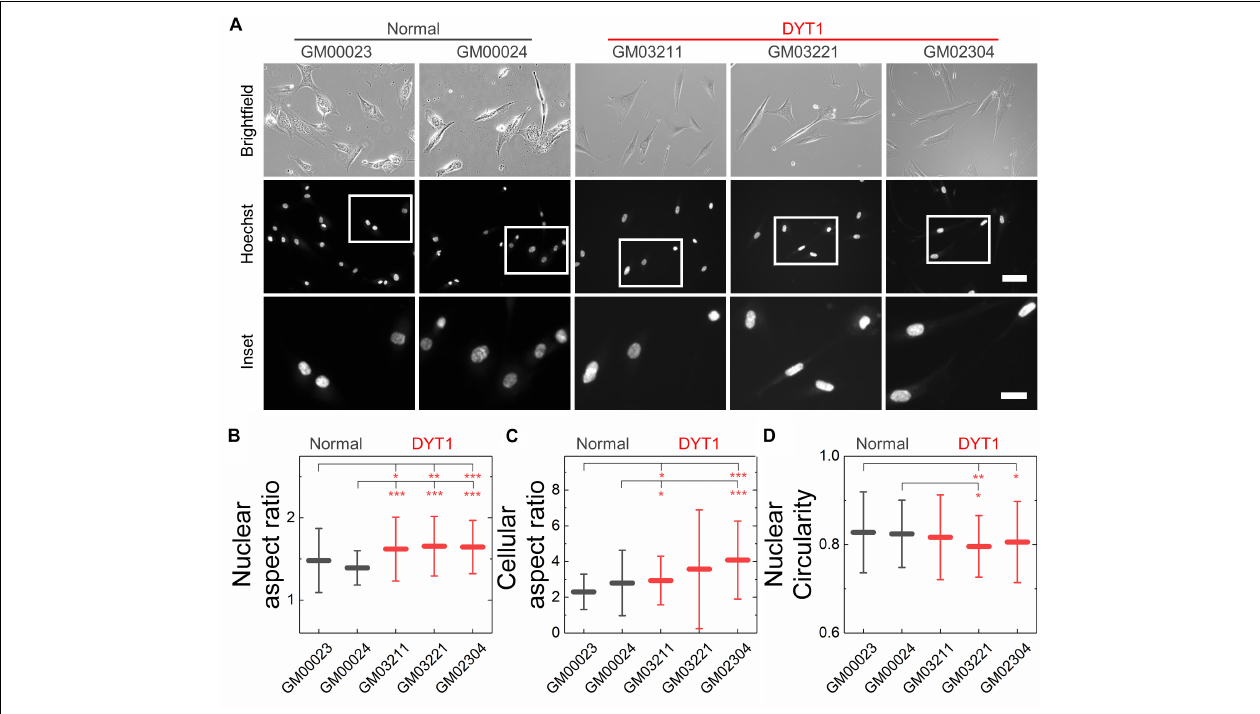
FIGURE 4 | DYT1 dystonia patient-derived fibroblasts and nuclei are slightly more elongated relative to controls but do not exhibit marked differences in shape. (A) Representative brightfield and epifluorescence images of normal and DYT1 dystonia patient-derived fibroblasts and their nuclei. Nuclei were labeled with the fluorescent DNA dye, Hoeschst 33342. Scale, 20 µ m. Inset: scale, 10 µ m. Quantification of (B) nuclear aspect ratio, (C) cellular aspect ratio, and (D) nuclear circularity. Each data point represents the mean ± SD. Data were obtained from N > 30 cells across three independent experiments. Statistical significance was determined using the Welch’s t -test. ∗∗∗ p < 0.001; ∗∗ p < 0.01; ∗ p < 0.05; and not significant (NS) p > 0.05 is not indicated on these plots for clarity.